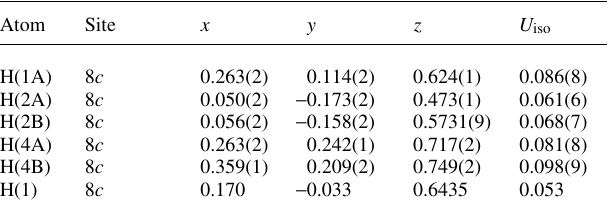
Table 2. Atomic coordinates and displacement parameters (in Å 2 )